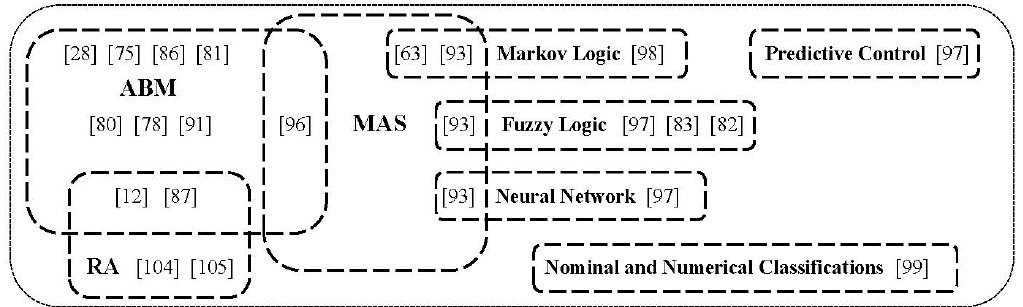
Figure 2. Framework of current